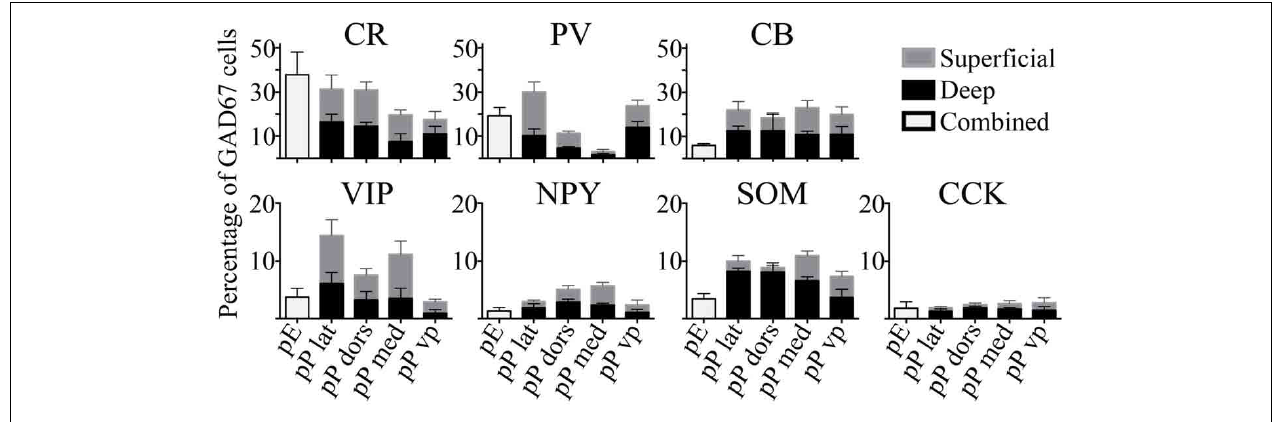
FIGURE 3 | The percentages of GAD67 cells that colocalize with the seven molecular markers tested vary by region. Labeled cells in the AON subdivisions [pars externa (pE), pars lateralis (pP lat), pars dorsalis (pP dors), pars medialis (pP med), pars ventroposterior